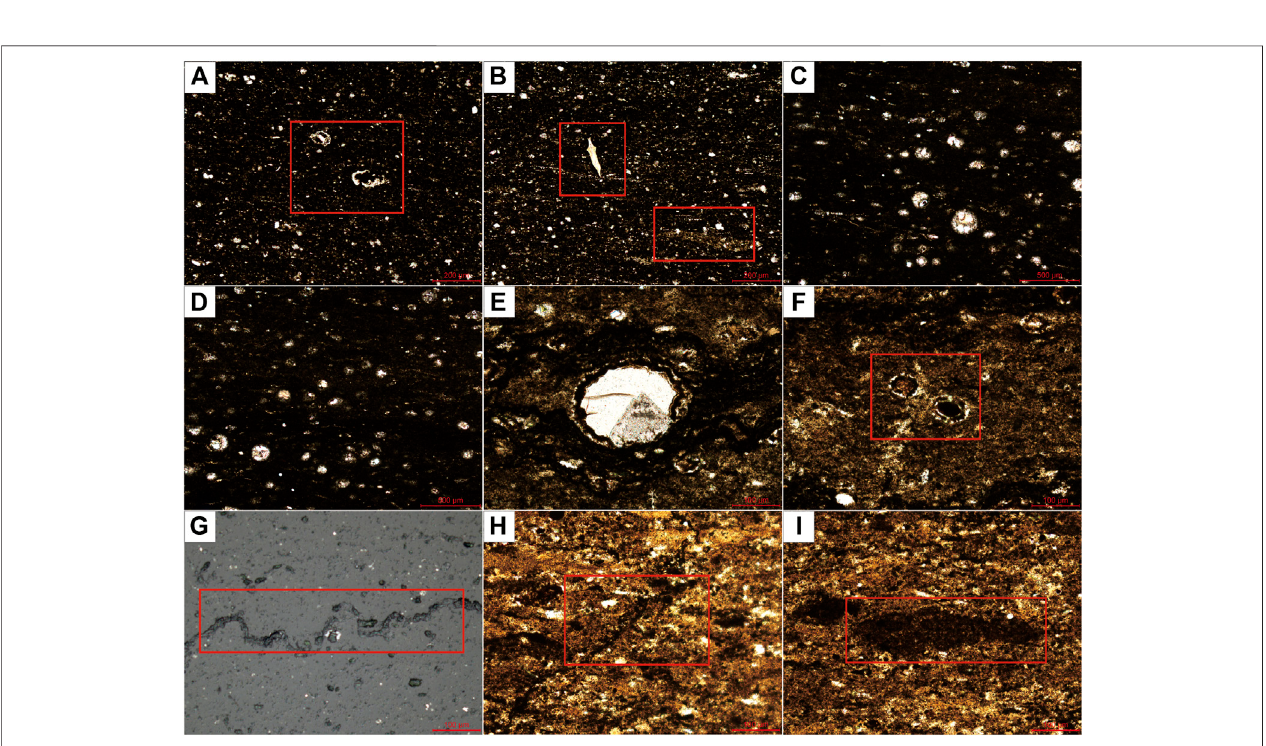
FIGURE 10 | Hydrocarbon-forming organisms above and below N22 volcanic ash layer. (A,B) Biological nail plate and algal debris, above N22 and close to N23; (C – F) : radiolaria, above N22; (G) worm trail, below N22; (H , I) benthic algal thallus, below N22.